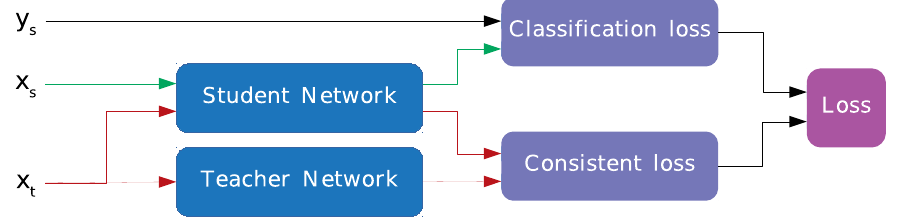
Figure 1. The structure of the mean teacher model implemented in this work, modified from (French et al.,